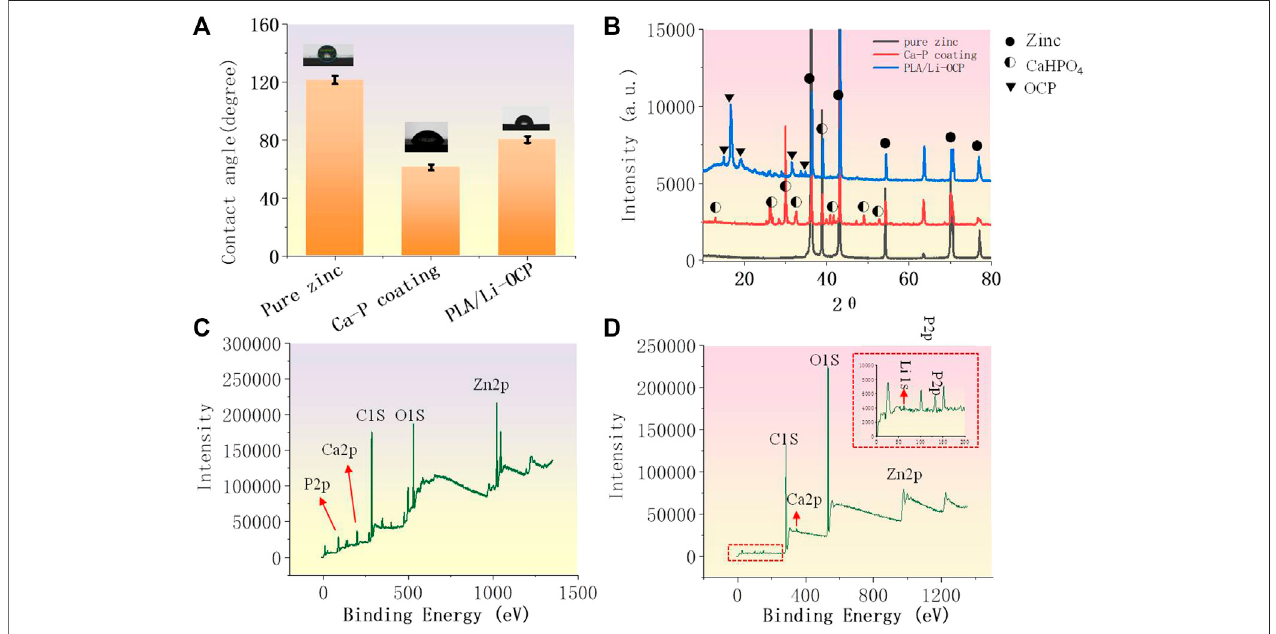
FIGURE 2 | (A) The contact angle of studied samples; (B) the XRD patterns; (C, D) the total XPS spectrum of the Ca-P coating and PLA/Li-OCP coating.